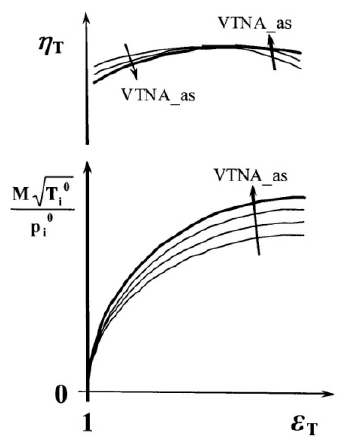
Figure 3. Typical VTNA turbine performance map.